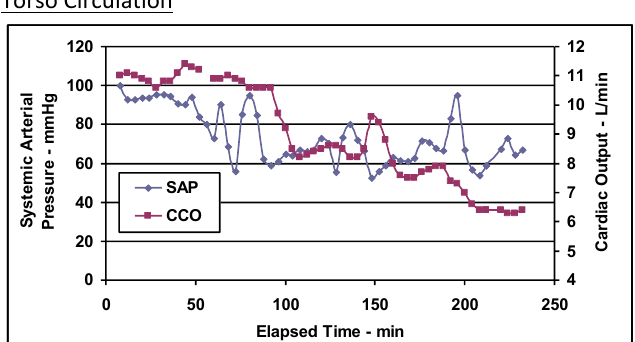
Figure 7. Systemic arterial pressure (SAP) and continuous cardiac output (CCO) vs. elapsed